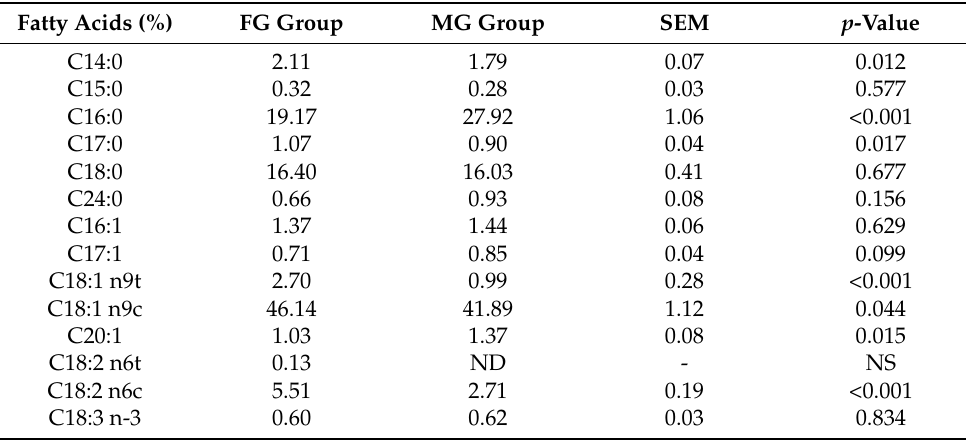
Table 4. Nutritional traits of longissimus thoracis (LT ) muscle of goats in two